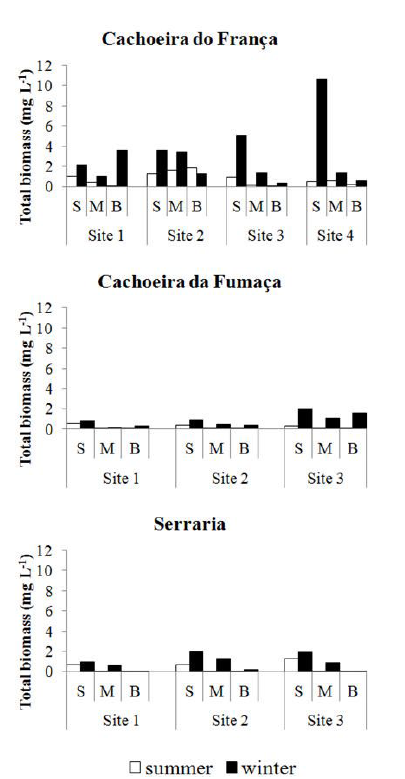
Figure 2. Phytoplankton total biomass (mg L -1 ) in three strata (S subsurface, M middle, B bottom layers) and sampling sites (1, 2, 3, 4) during the winter and summer at the three cascading reservoirs.